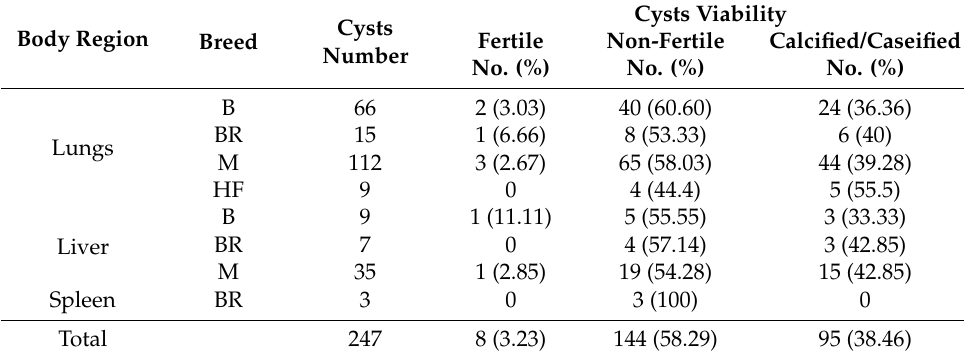
Table 3. Viability of E. granulosus cysts in